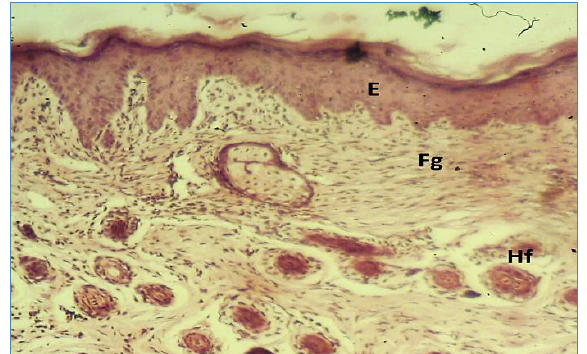
Figure, 17: Section of skin (21 days post treatment with amniotic membrane) shows: epithelium (E) organized fibroblast (Fg) and hair follicle (Hf). H and E, 100x.